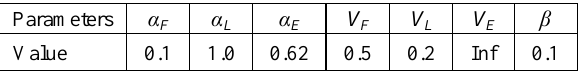
Table 1. The parameters set for